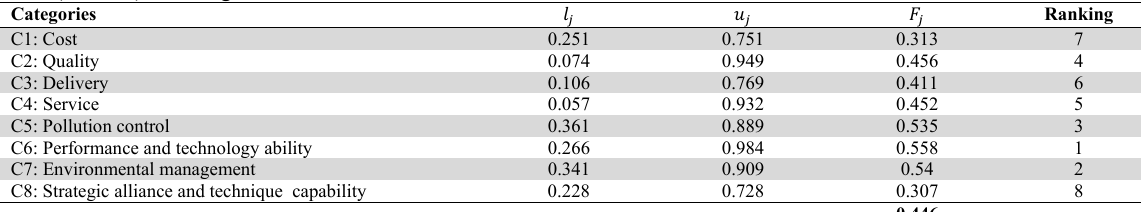
FDM (round 2) for categories Categories